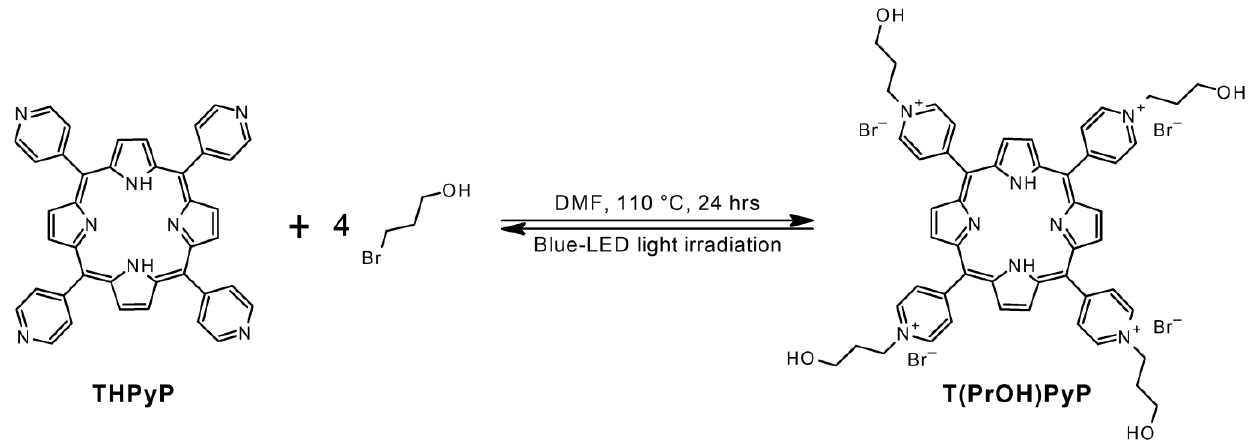
Figure 4. Photobleaching of ( A ) free porphyrins and ( B ) encapsulated porphyrins. Free porphyrins were dissolved in DMF at 5 µM, while nanoparticles were suspended in PB pH 7, at 5 µM of their respective porphyrin. Three milliliters of both solutions were deposited in an open quartz square cell of 1 cm width, with constant stirring, under blue-LED light irradiation (100 mW/cm 2 ), under several lapses. The normalized absorbance is presented and the results presented are the average of two independent experiments.